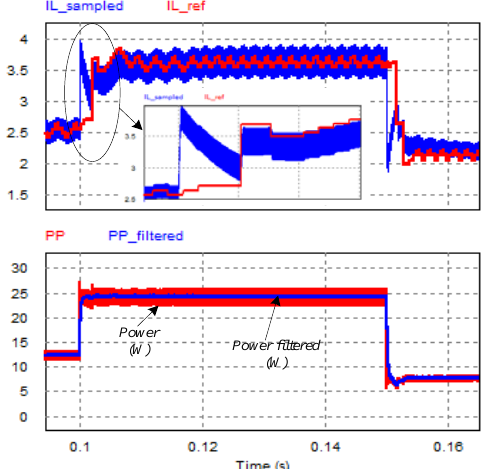
Figure 8. Simulation results of the proposed MPPT algorithm.